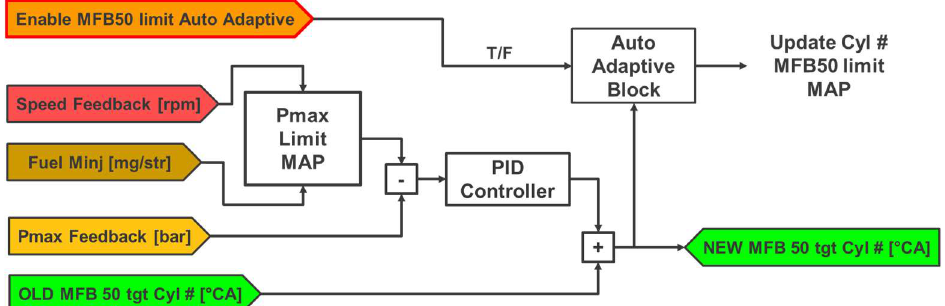
Figure 10. Adaptation strategy used to update the MFB50 Limit Map.